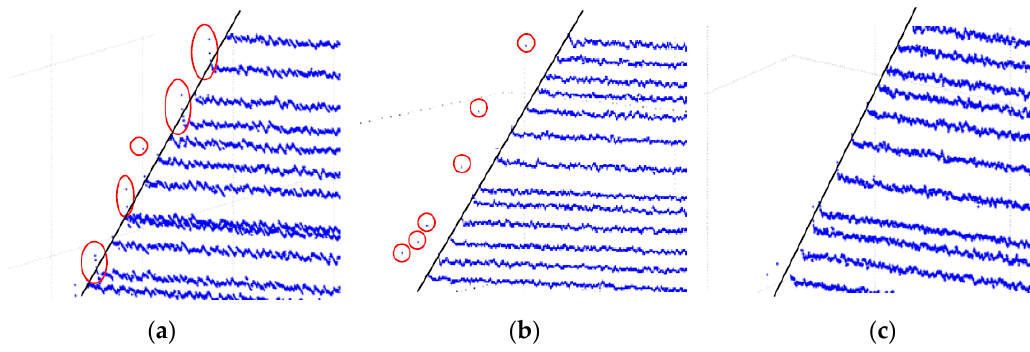
Figure 13. Local reconstruction details on the boundary. ( a ) Geometric center method; ( b ) Centroid of Gray (COG); ( c ) feature compression extraction method.